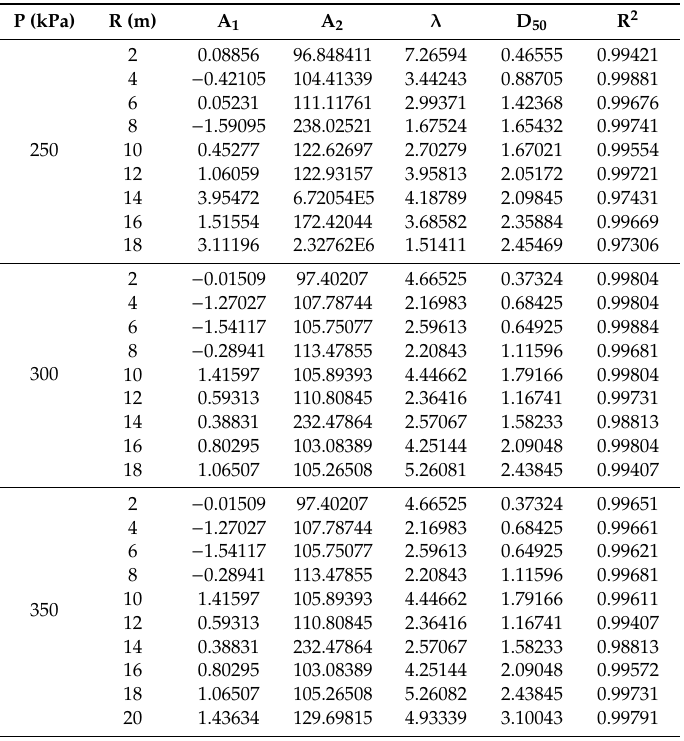
Table 3. Regression parameters A 1 , A 2 , λ , D 50 and R 2 for the model equation using the CVF at 250, 300, 350 kPa operating pressure along the radial